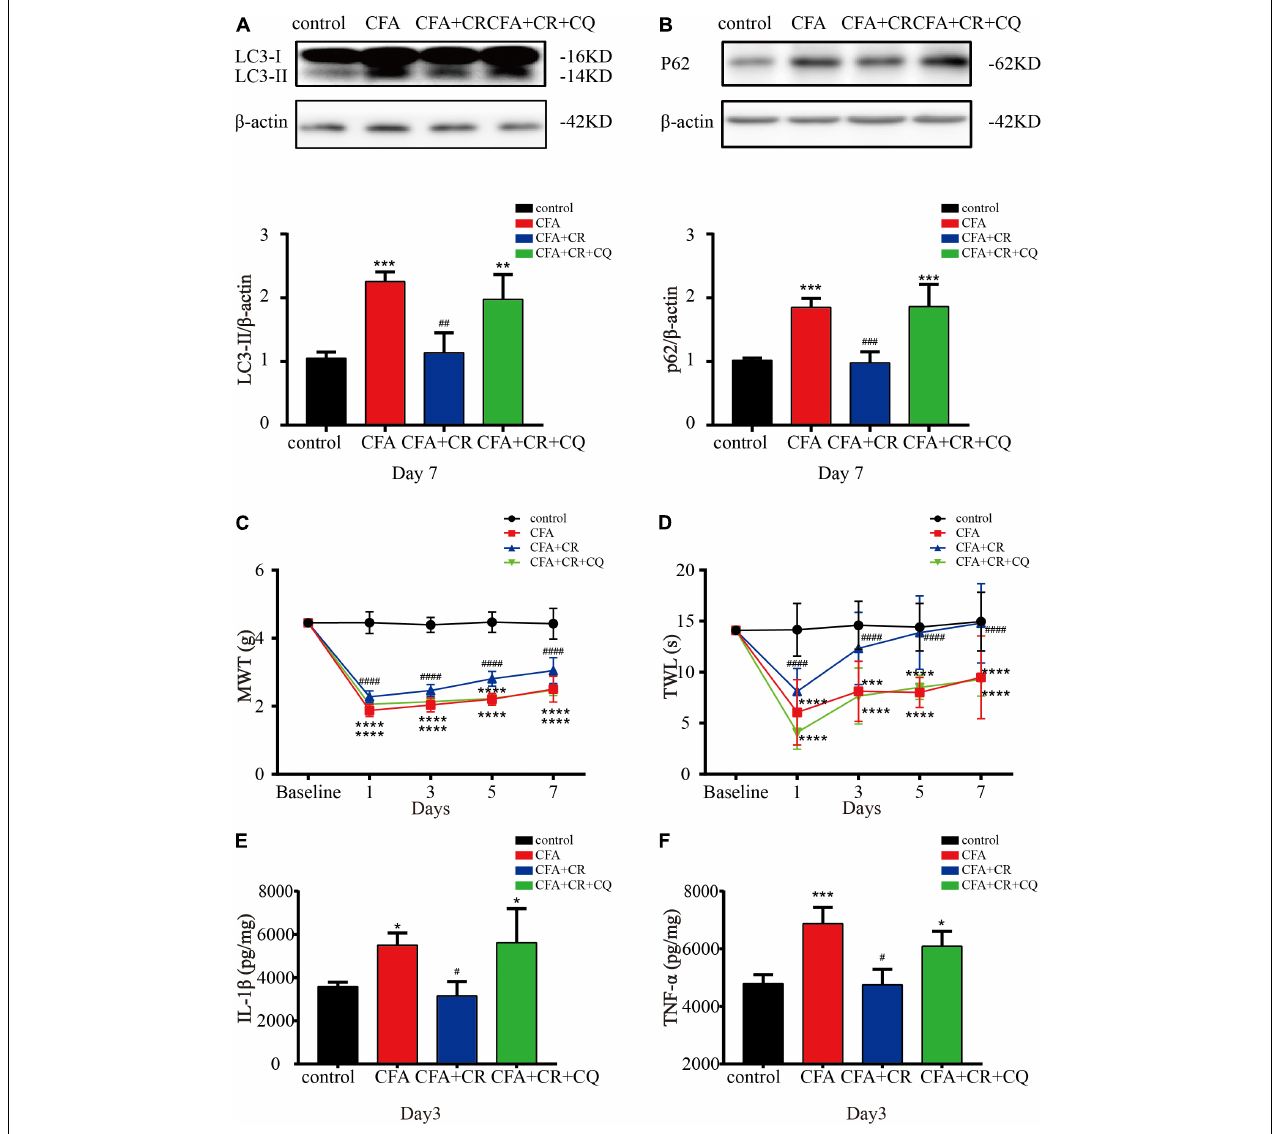
FIGURE 4 | CR improves CFA-induced inflammatory pain by restoring autophagic flux. Protein expressions of LC3-II (A) and p62 (B) of mice in the control group, CFA group, CFA + CR group and CFA + CR + CQ group. Values are expressed as the mean ± SD and were analyzed by one-way analysis of variance, followed by a Turkey’s post-hoc test, n = 4 per group. ∗∗∗ P < 0.001, ∗∗ P < 0.01, compared to control group; ### P < 0.001, ## P < 0.01, compared to the CFA + CR + CQ group. (C) The mechanical withdrawal threshold (MWT) tests and (D) thermal withdrawal latency (TWL) tests of mice in the four groups. Values are expressed as